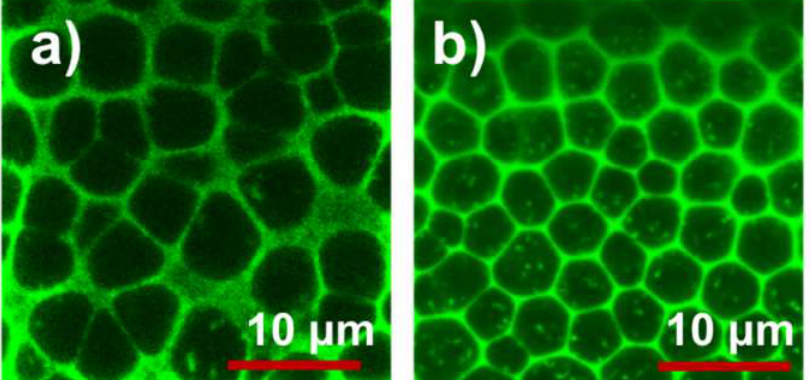
Figure 6. Confocal microscopy images of reference cell ( a ) and A3DA‐PDLC film ( b ) with 0.1 wt% of dye. The images were collected near the film‐cover glass interface (UV light exposed area).